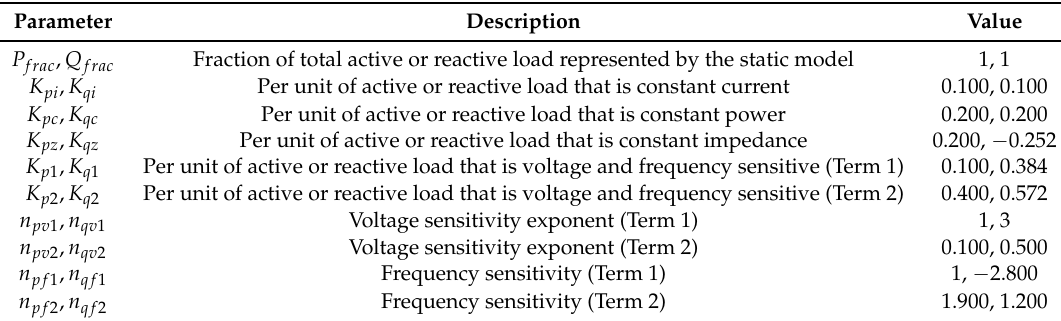
Table 6. Load data description and values.